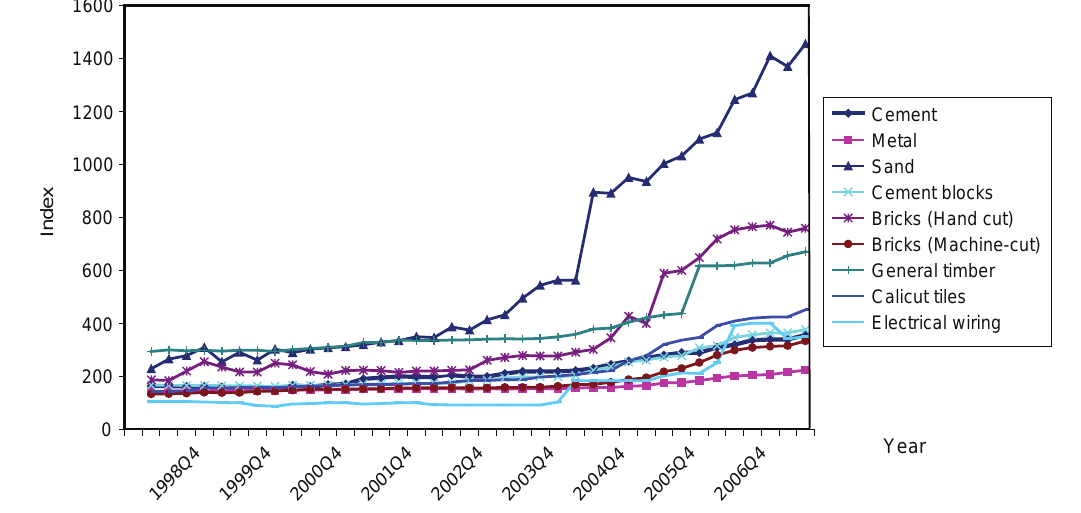
Figure 3. selected construction material price